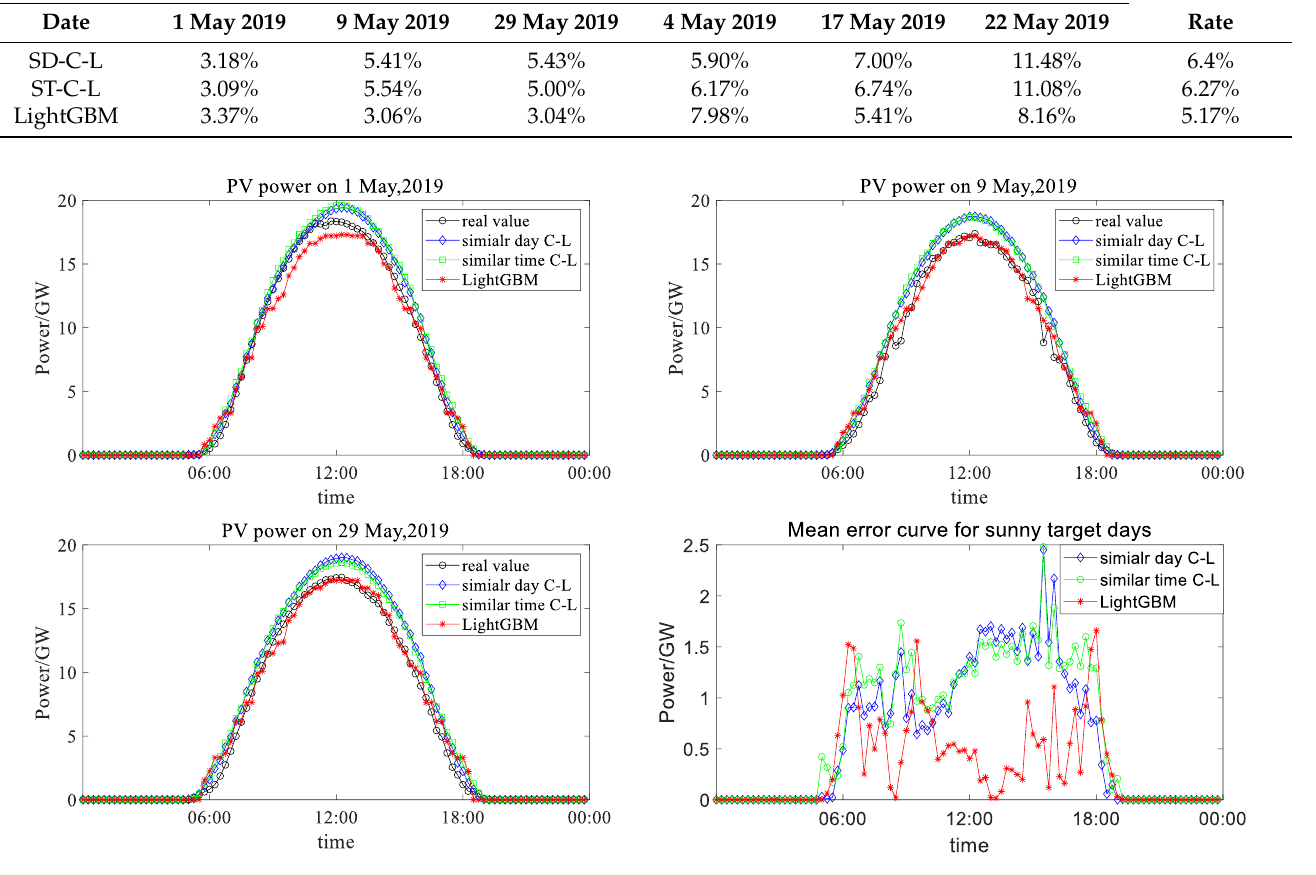
Figure 11. Predicted power and mean error curves for non-sunny target days. Similar to the nomenclature in Table 4, the prediction results obtained by using sim- ilar-day data as training data for the 1DCNN-LSTM are referred to as “ similar-day C-L ” . The prediction results obtained by using similar-time data as training data for the 1DCNN-LSTM are referred to as “ similar-time C-L ” and the end results achieved by inte- grating the two prediction results using LightGBM are called “ LightGBM ” . As can be seen